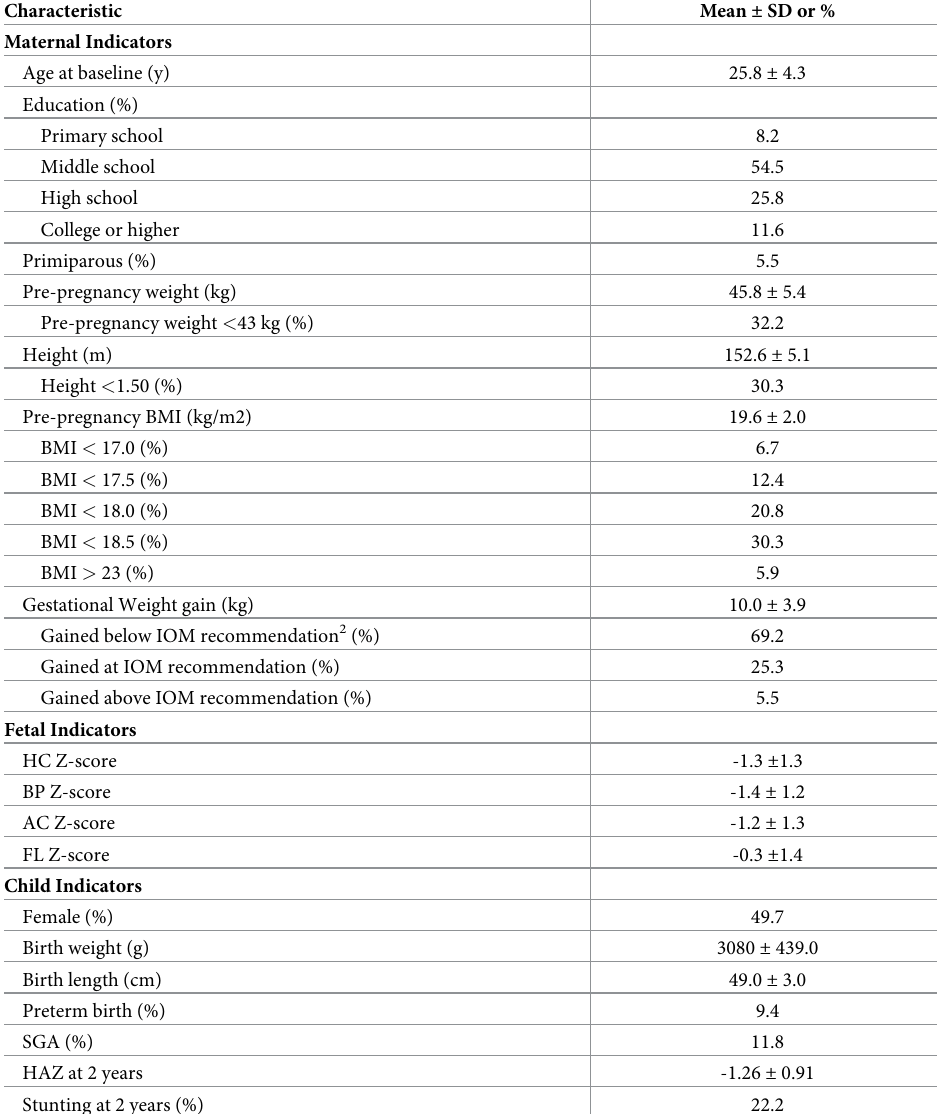
Table 1. Maternal and newborn characteristics (n = 1409) 1